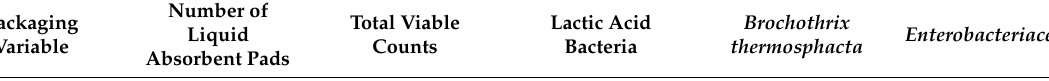
Table A4. Microbiological content measured as total viable count of bacteria (TVC), lactic acid bacteria (LAB), Brochothrix thermosphacta, and Enterobacteriaceae given as log cfu/g for chicken breast fillets (Experiment 1 and 2) as a function of storage time, packaging variables, gas composition (60% CO 2/ 40% N 2 and 25% CO 2/ 75% O 2 ), or g/p ratio (1.8, 2.9, 2.0 and 2.1), with 0, 1, or 2 liquid absorbent pads. Sampling times after 6 (7), 14, and 20 days of cold storage. Values are mean ± standard deviation ( n =